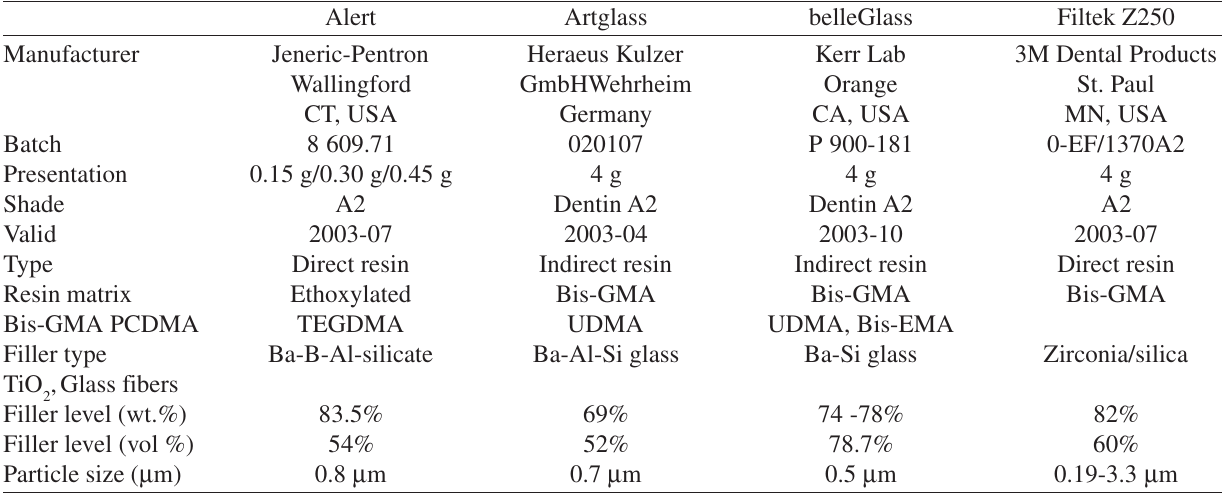
Table 1 . Description of